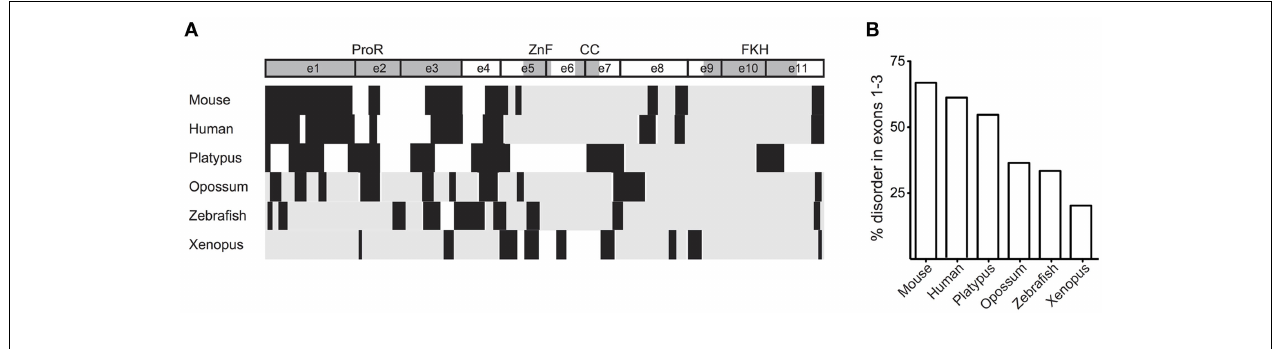
species. Since not all Foxp3s have a ProR, the part of the N-terminal region having the best alignment to mouse Foxp3 was chosen from these